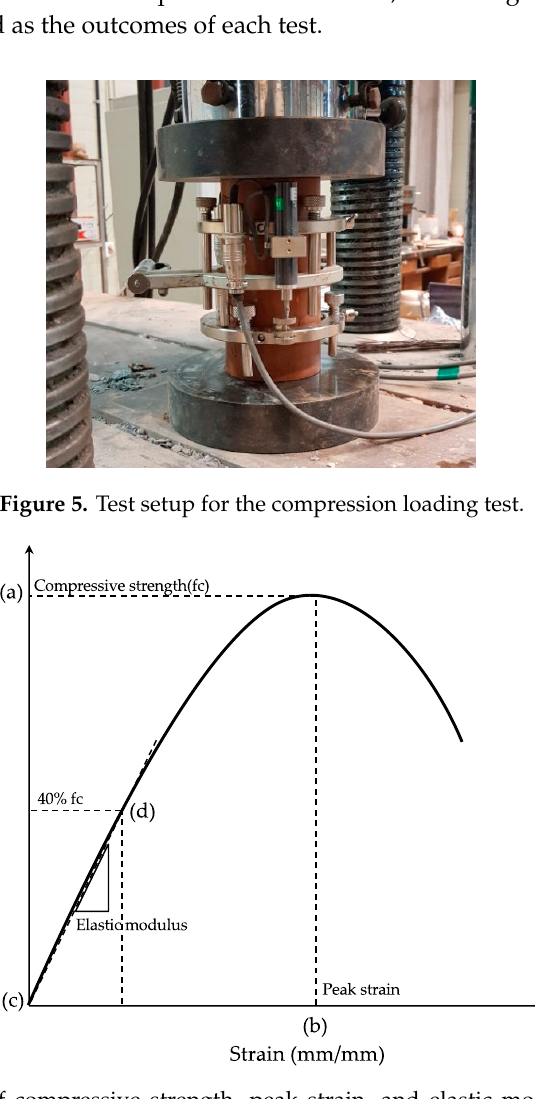
Figure 6. Definition of compressive strength, peak strain, and elastic modulus on stress–strain curve (SSC).